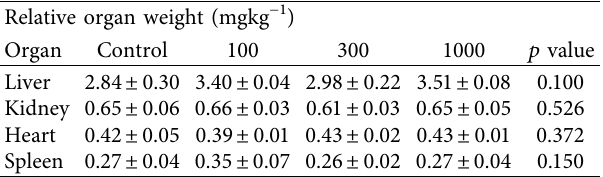
Organ body indices of AAE-treated rats with the negative control group. Te values are given as mean ± S.E.M. ( n � 5). Te data were analysed using one-way ANOVA with ( p > 0 .